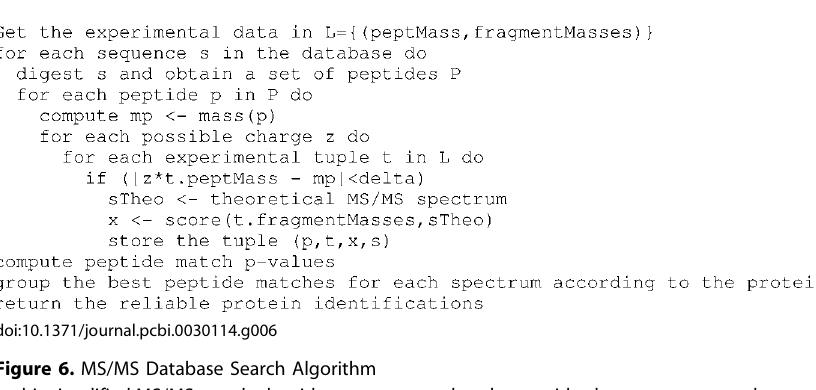
Figure 6. MS/MS Database Search Algorithm